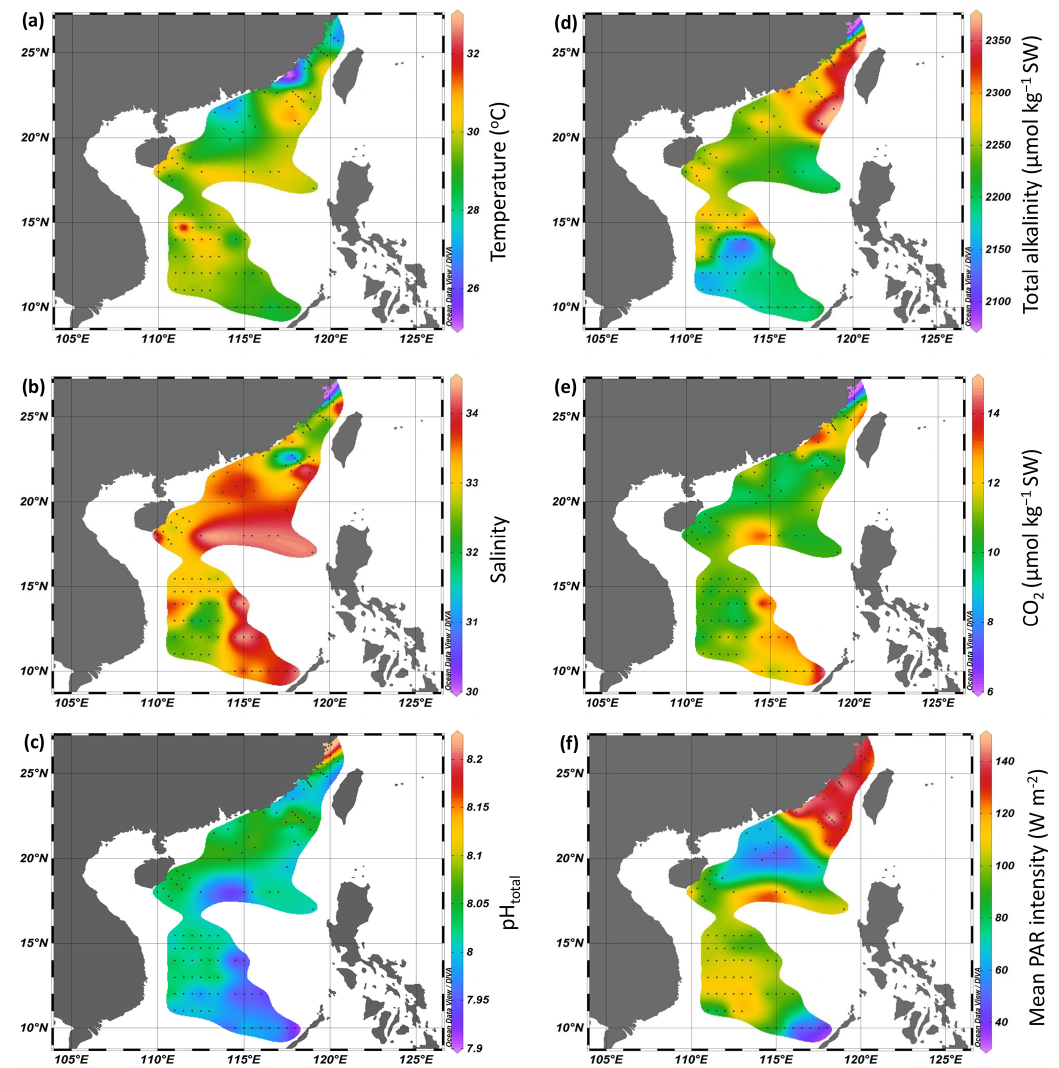
Figure 2. Temperature ( ◦ C, a ), salinity (b) , pH total (c) , total alkalinity (µmolkg − 1 SW, d ), and CO 2 (µmolkg − 1 SW, e ) in surface seawater (SW) and mean PAR intensity (Wm − 2 , f ) during the PP incubation